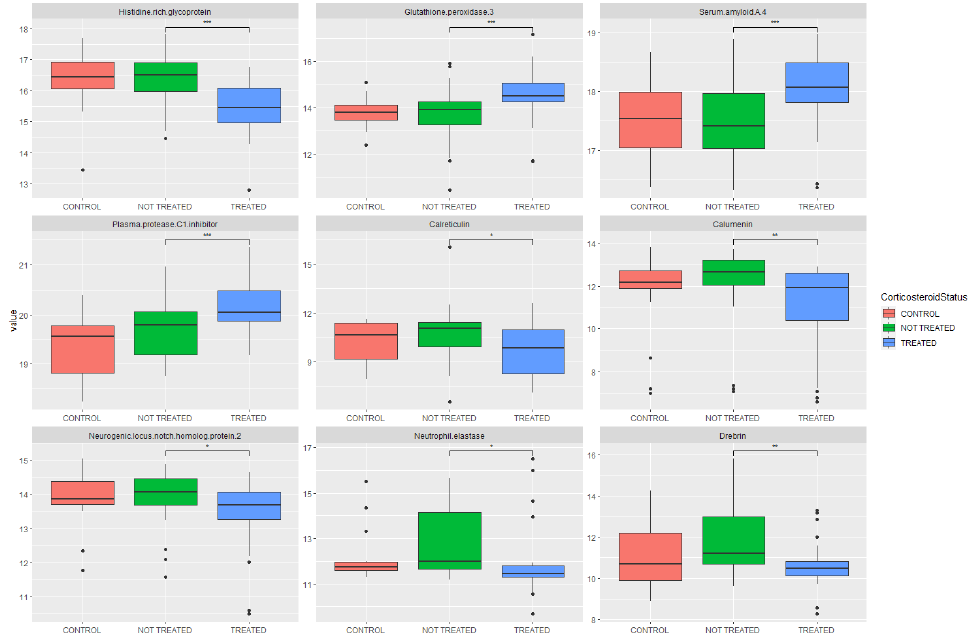
Figure 3. Boxplots of significantly altered metabolites. Plots show a control group for comparison (COVID ‐ 19 negative, not treated with glucocorticoids), COVID ‐ 19 positive (not treated with glucocorticoids) and COVID ‐ 19 positive (treated with glucocorticoids). Statistical significance is shown between treated and untreated cohorts. * indicates p ≤ 0.05, ** indicates p ≤ 0.01, *** indicates p ≤ 0.001.